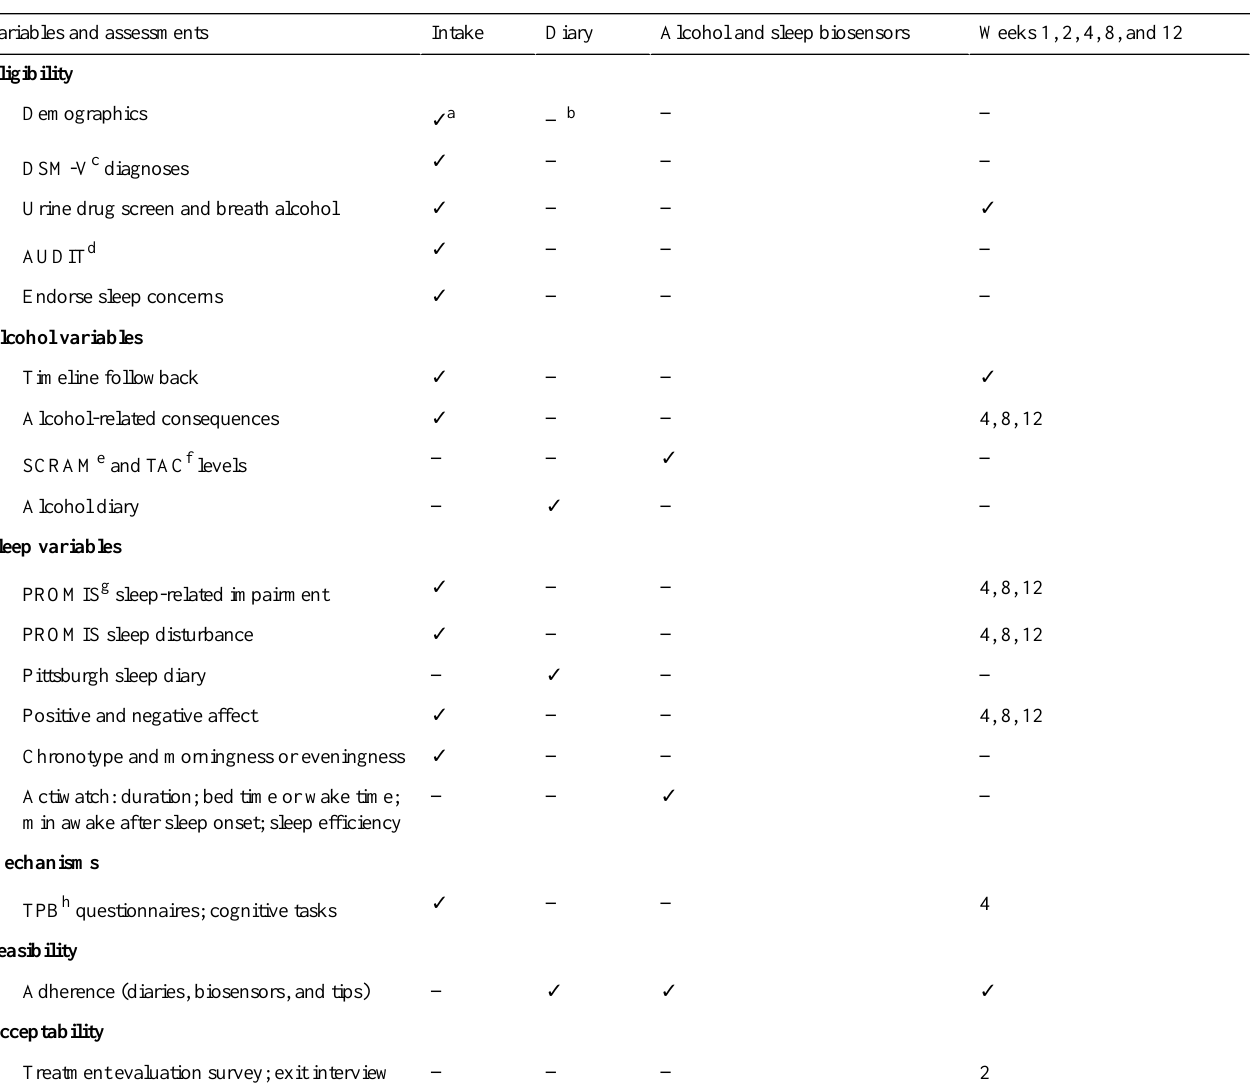
Table 2. Schedule of